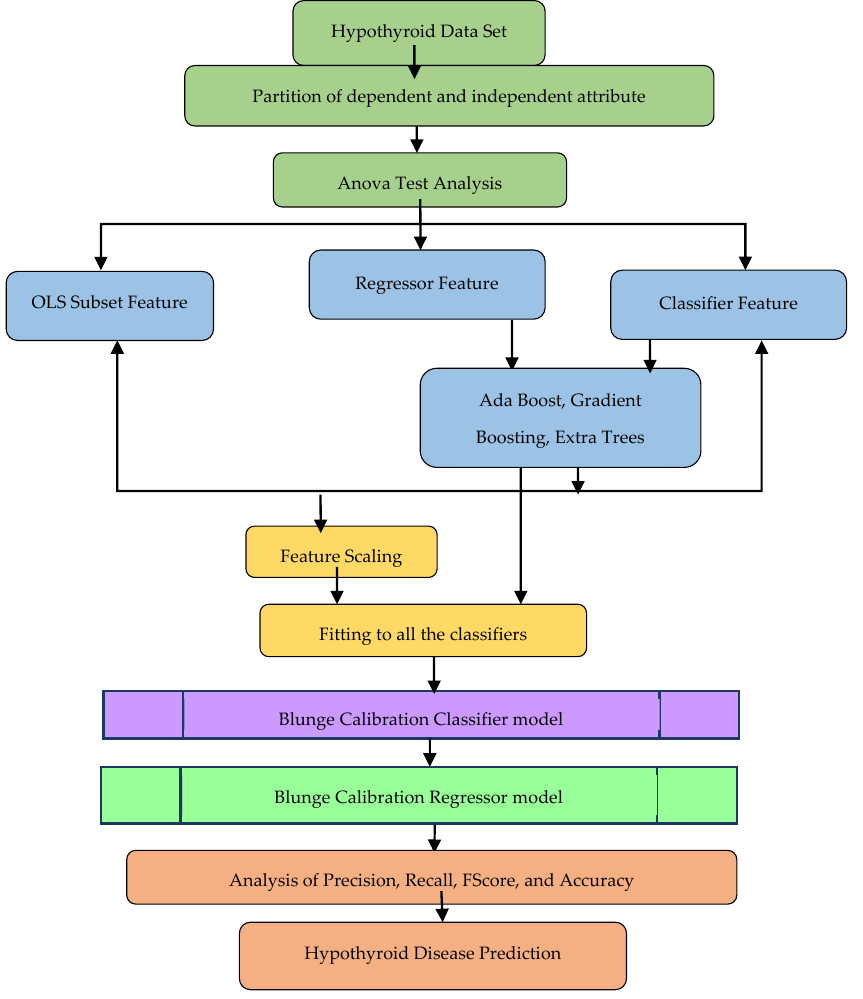
Figure 1. Proposed system workflow.